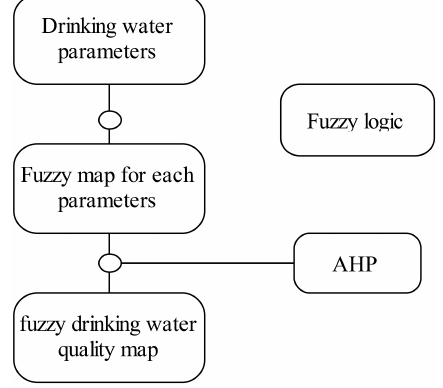
Figure 4. Fuzzy AHP procedure for drinking water quality based on content of inorganic